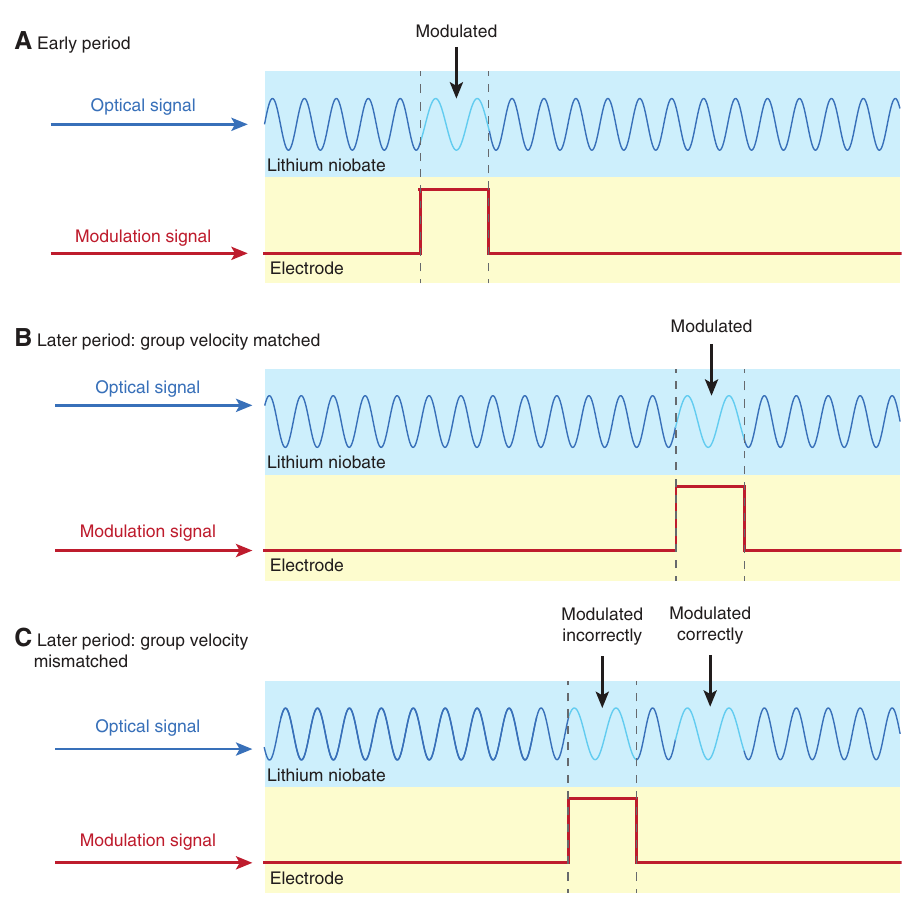
Figure 17: Schematic of group velocity matching of high-speed traveling-wave modulators. (A) In early period, certain part of the optical signal is modulated by the microwave signal. (B) If group velocity of optical signal matches that of the microwave signal, optical signal will be modulated by the same electric field consistently, resulting in velocity-matched electro-optic modulation. (C) If group velocity of optical signal does not match that of the microwave signal, optical signal will not be modulated by the same electric field consistently. Such a velocity-mismatched electro-optic modulation may introduce phase error to the modulated optical signal, especially when modulation frequency is high; that is, wavelength of the modulation signal is shorter than the electrode